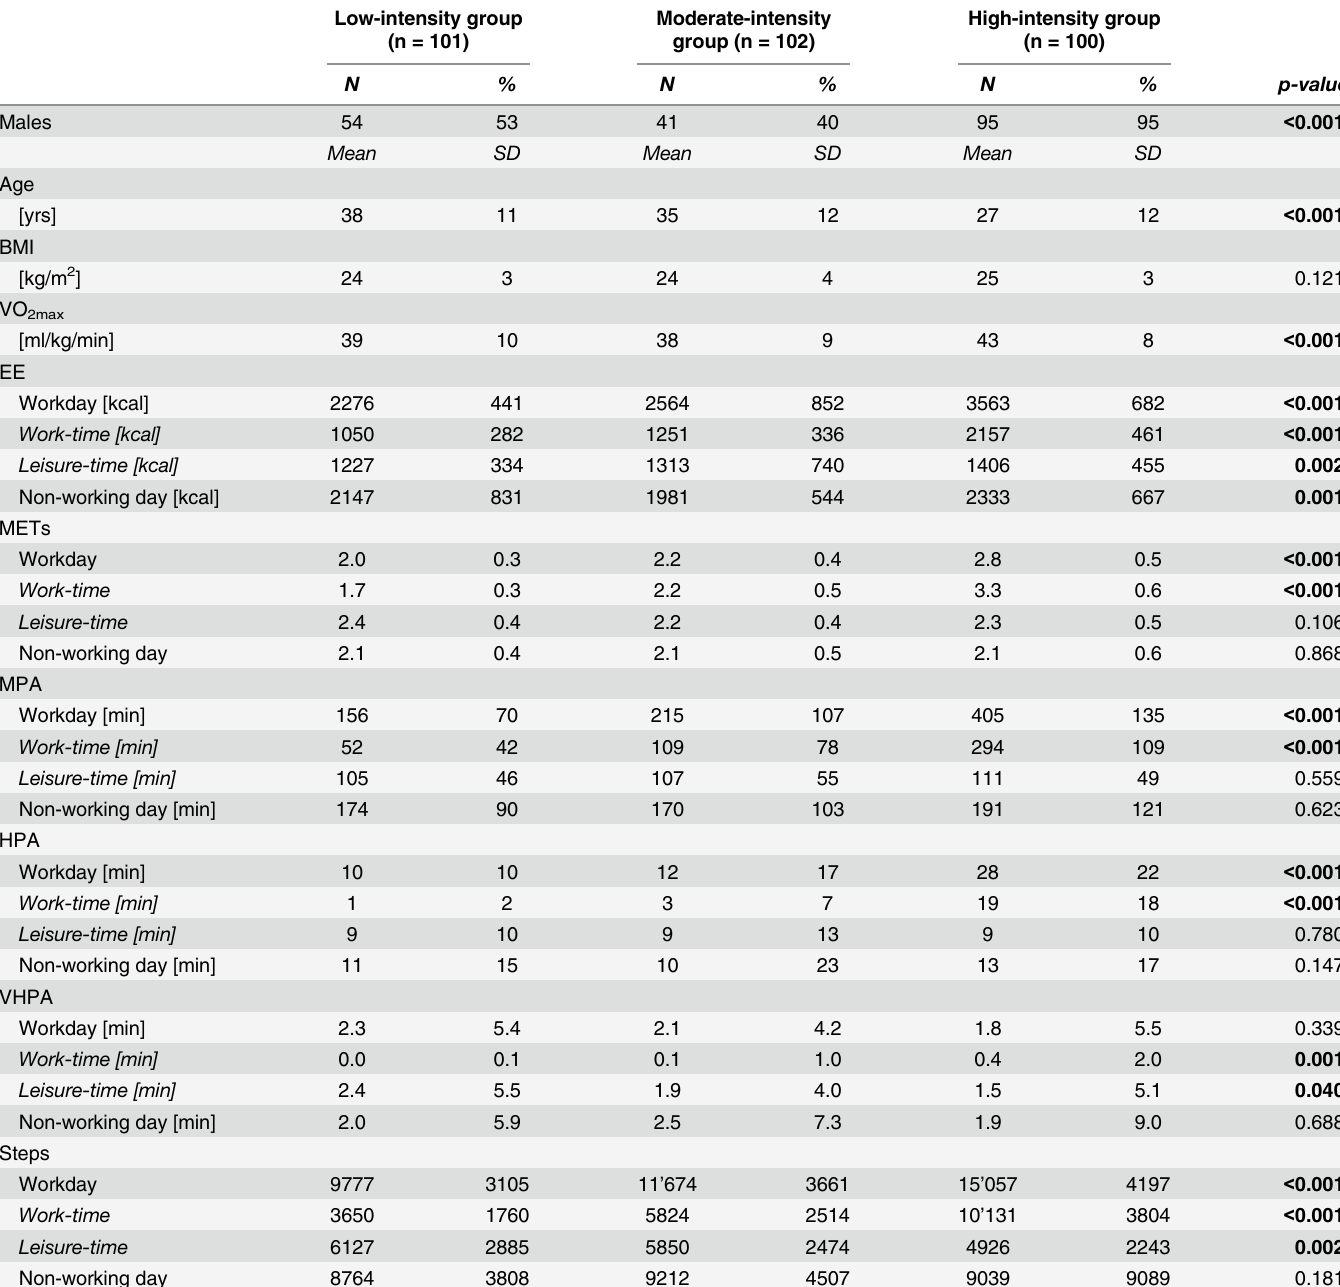
Table 1. Aerobic capacity and objective SenseWear activity data across occupational groups (n =